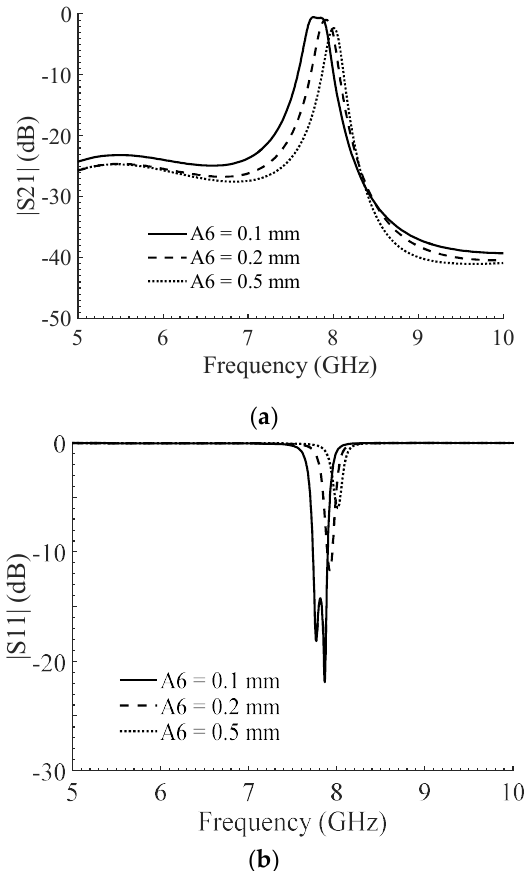
Figure 4. Adjustability of the lower passband by varying A6: ( a ) |S21|, ( b ) |S11|.